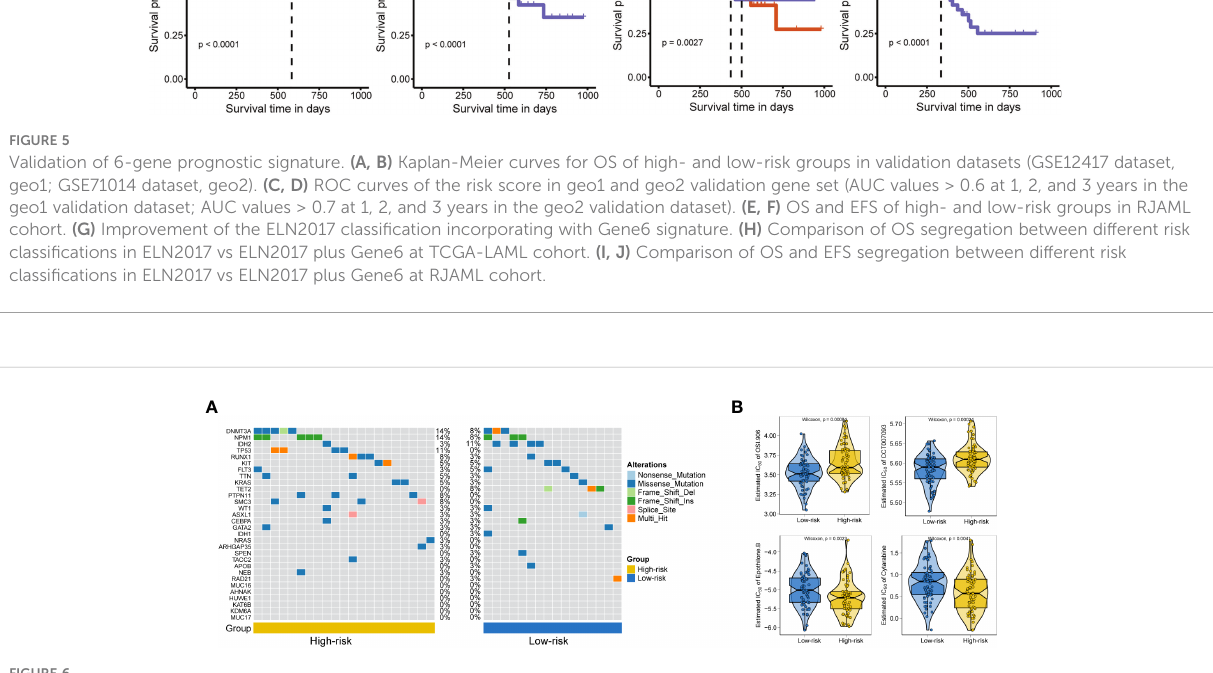
FIGURE 6 Gene mutation analysis and drug sensitive prediction in AML patients. (A) Oncoplots showing AML-related gene mutation frequencies among high- risk group and low-risk group in AML patients. (B) Violinplots showing the mean differences in estimated IC50 values of 4 representative drugs (OSI.906, CCT007093, Epothilone.B, Cytarabine) between the two risk groups.